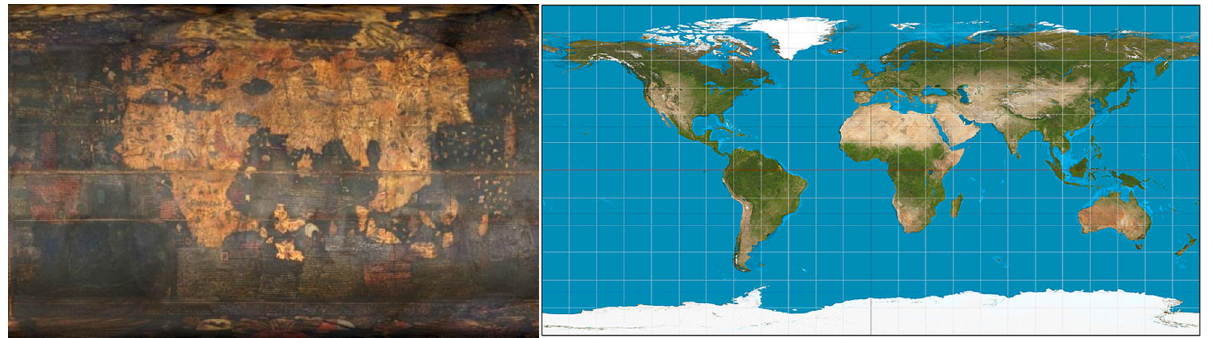
Fig. 9: Equirectangular projection of the Behaim globe compared to the actual